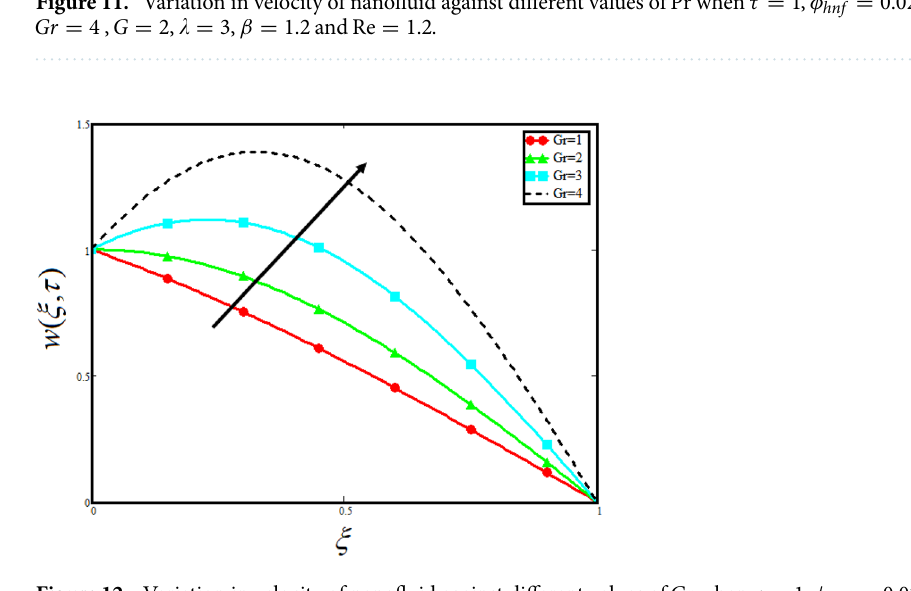
Figure 12. Variation in velocity of nanofluid against different values of Gr when τ = 1 , φ hnf = 0.02 , Pr = 21 , α = 0.5 , G = 2 , (cid:31) = 3 , β = 1.2 and Re = 1.2